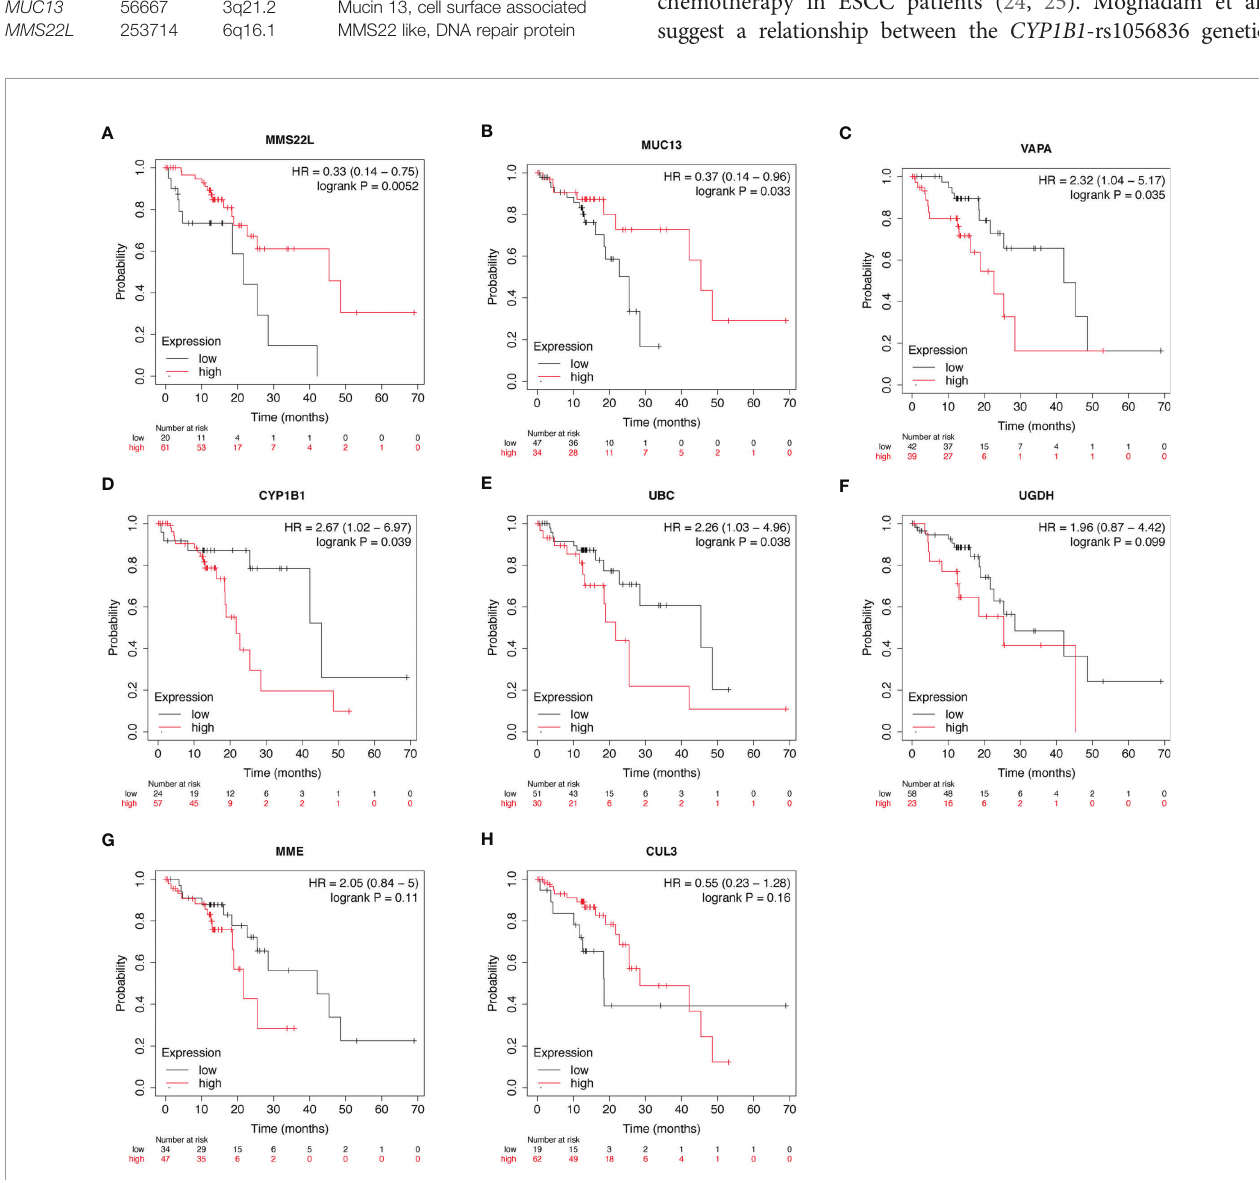
FIGURE 3 | Prognostic value of mRNA expression of eight genes in patients with ESCC. (A – H) Overall Survival curves of MMS22L (A) , MUC13 (B) , VAPA (C) , CYP1B1 (D) , UBC (E) , UGDH (F) , MME (G) , and CUL13 (H) were plotted in Kaplan-Meier plotter. “ Probability ” on the y-axis represents the survival rates, the red line represents the patients with mRNA expression above the median, and the black line represents the patients with mRNA expression below the median. ESCC, Oesophageal squamous cell carcinoma; HR, hazard